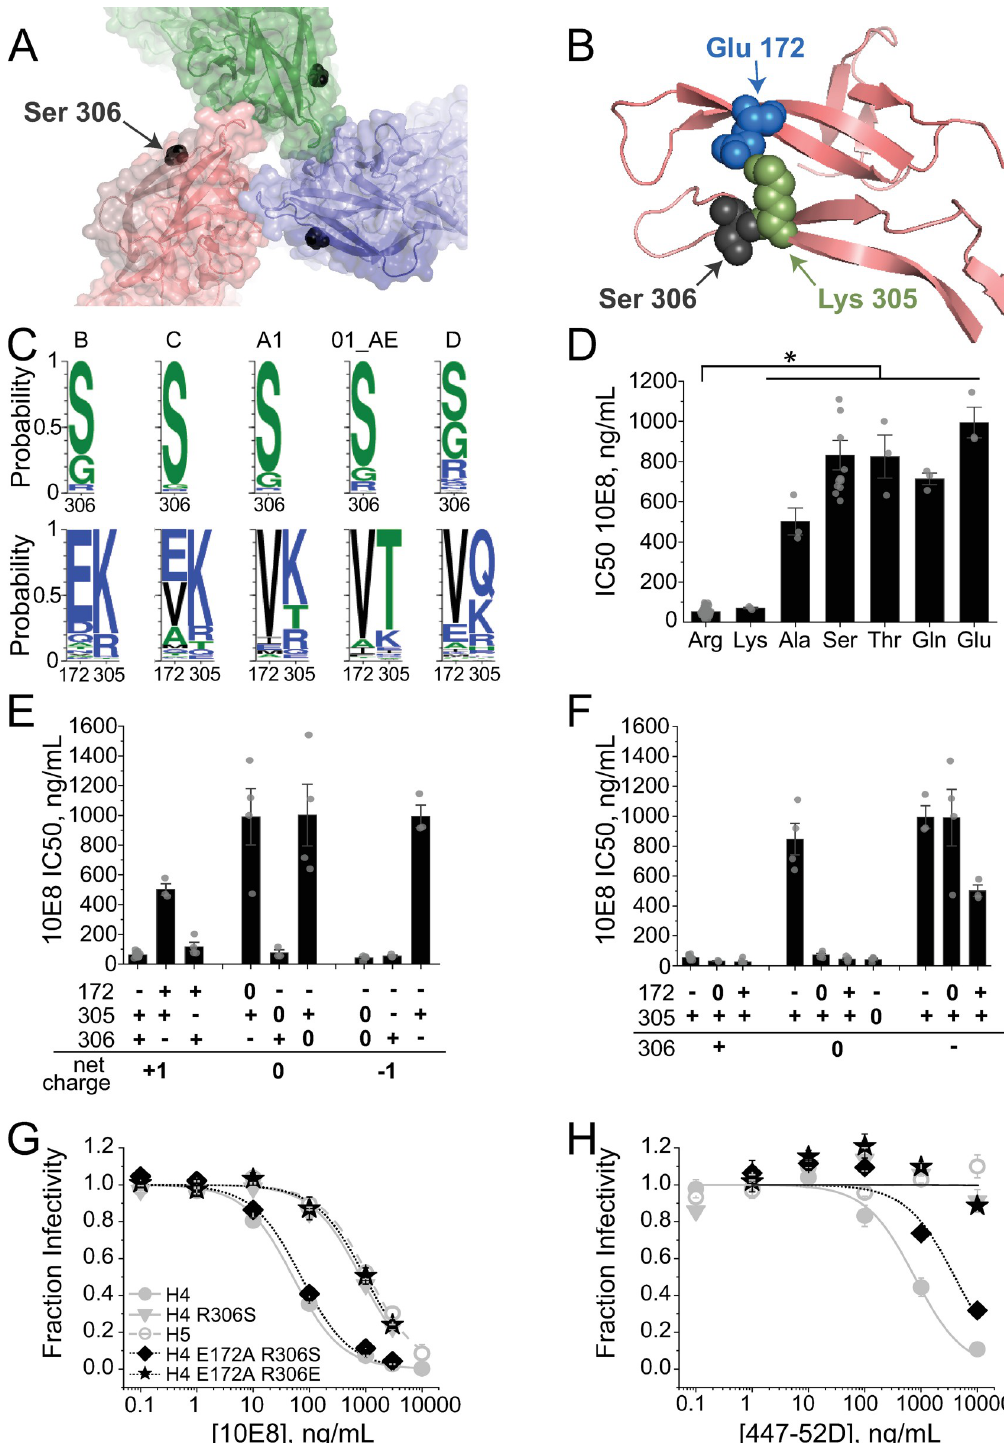
Fig 8. The charge at V3-loop residue 306 regulates gp41 MPER accessibility in H4 Env through short-range intrasubunit interactions. ( A ) Surface and ribbon rendering of the apical structure of Env JRFL SOSIP.664 (PDB 5FYK [79]) showing the position of residue 306 (Ser, black). ( B ) Ribbon diagram of the V1/V2 and V3 loops from one gp120 subunit highlighting V1/ V2-loop residue Glu172 (blue) and V3-loop residues Lys305 (green) and Ser306 (black). ( C ) Logos plots showing residue conservation at position 306 (top) and positions 172 and 305 (bottom) across different HIV-1 clades. Plots were obtained